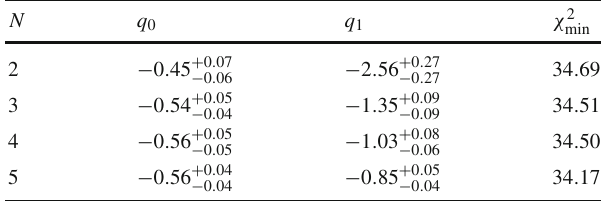
Table 1 Results of statistical analysis (within 1 σ confidence level) for Model 1 by considering different values of N . Here, χ 2 minimum value of χ 2 . For this analysis we have considered SNIa